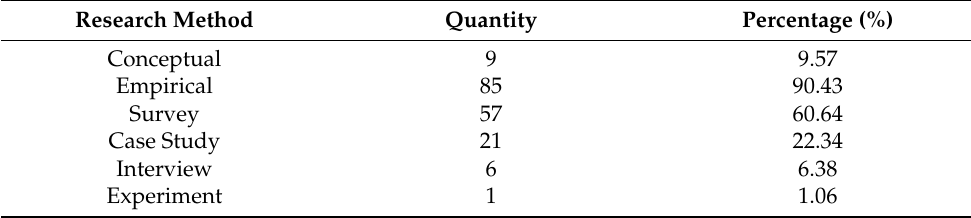
Table 3. Research methods.